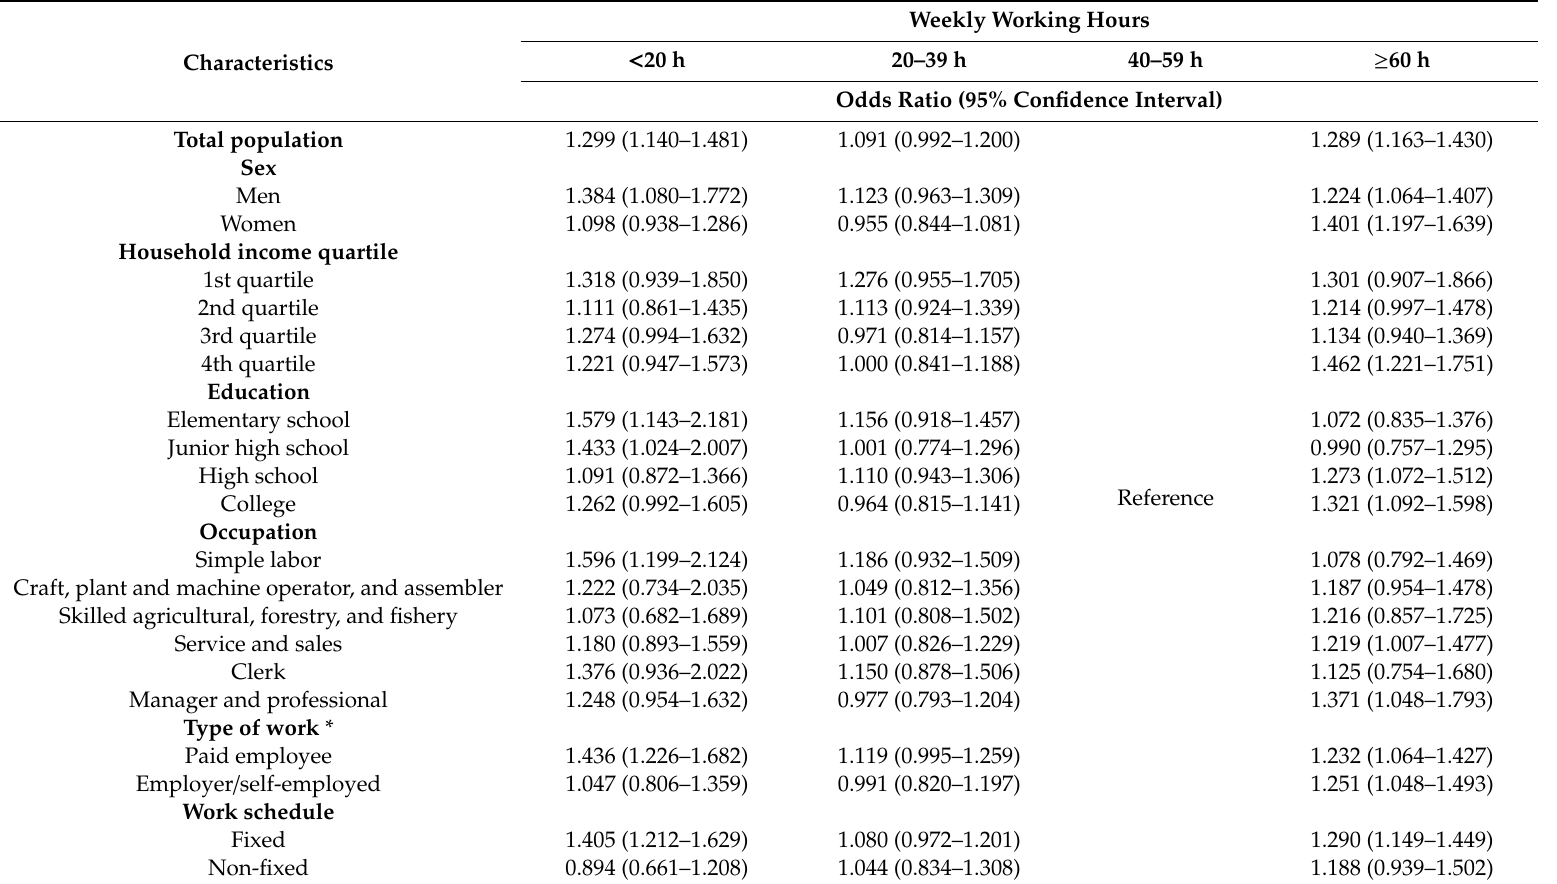
Table 2. Risk of poor self-rated health according to weekly working hours from multivariable logistic